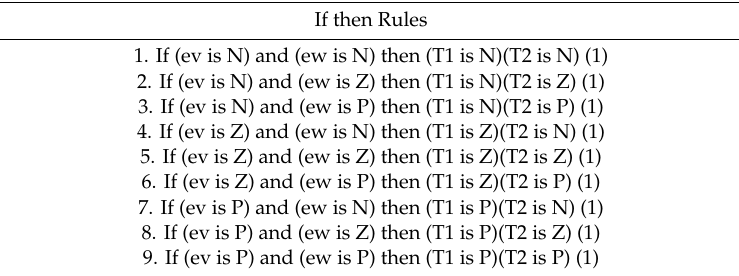
Table 5. If-then fuzzy rules.N: negative, P: positive, Z: zero.